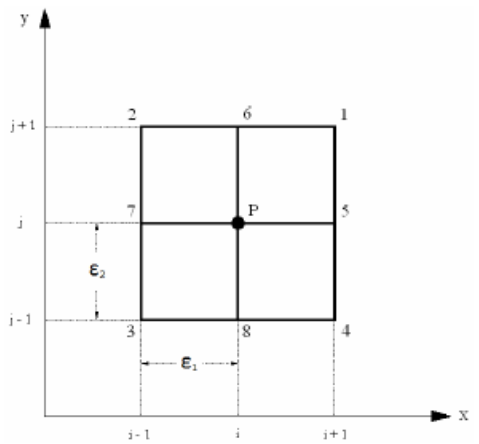
Fig. 2. Two-dimensional LISA discretisation model used for Lamb wave